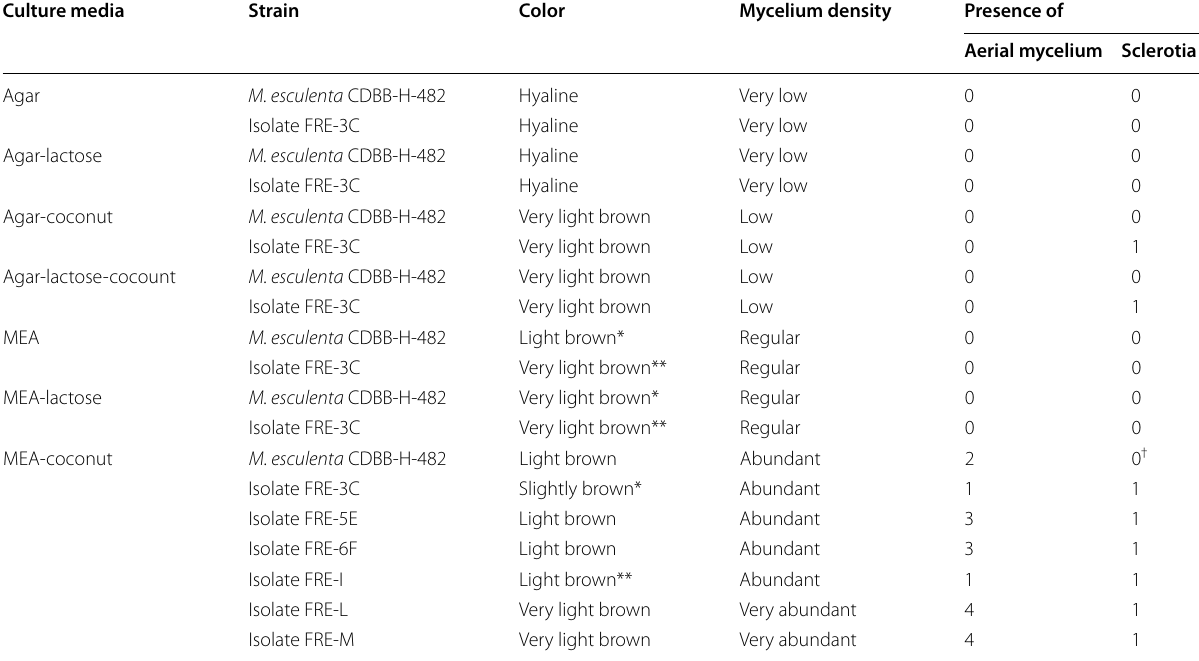
† Presence of young sclerotia (Volk and Leonard 1990) * Over time mycelium turns into brown ** Over time mycelium turns into dark brown